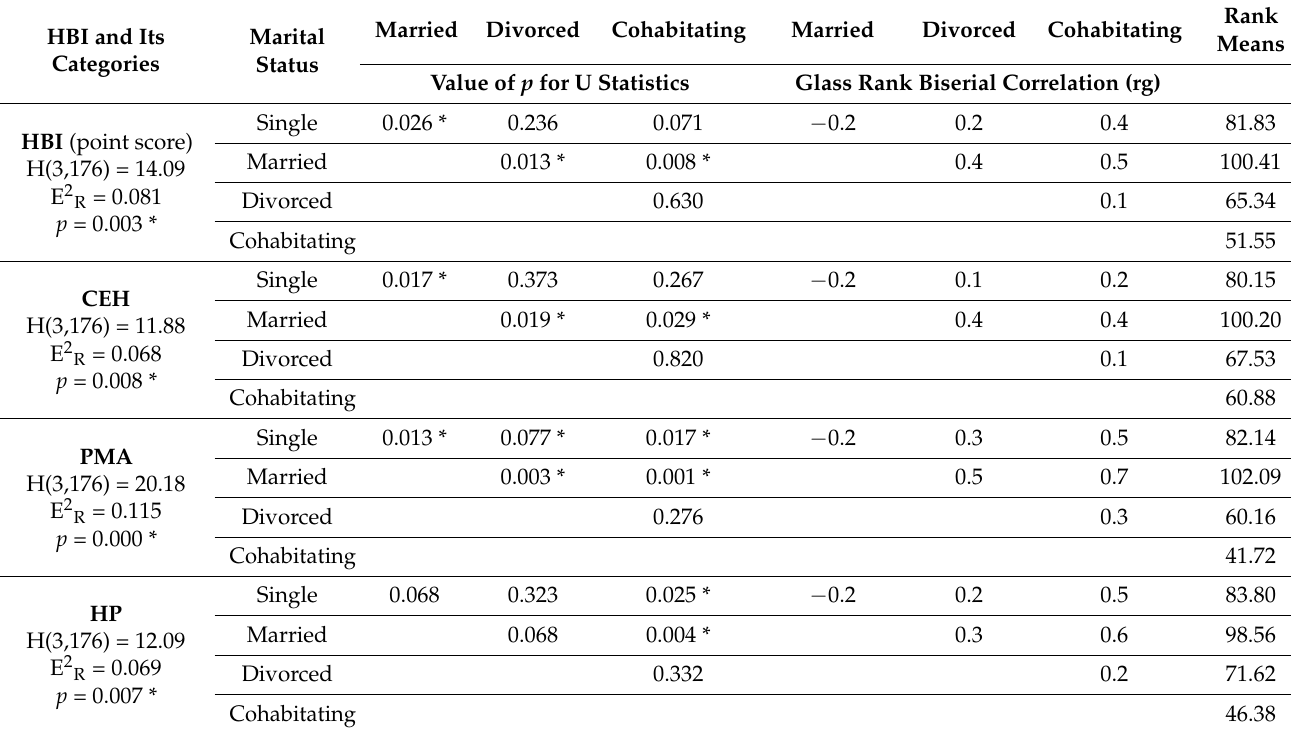
Table 8. Health behaviors of people practicing wheelchair basketball, wheelchair rugby and para- rowing depending on marital status (the H test, E 2 R , the U test,